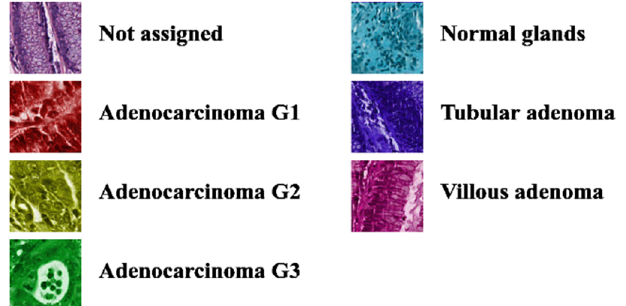
Figure 9. Examples of CNN predictions. The patches were painted when the predicted class probability was greater than 0.5.